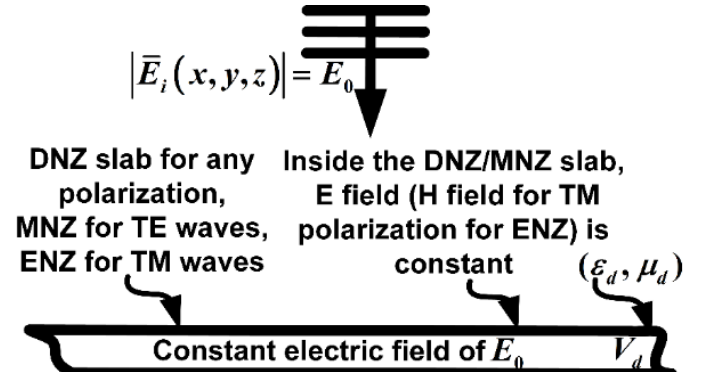
Figure 1. The entire DNZ slab has a constant electric field upon incident of fields with any polari- zation. For TE and TM polarized waves, the same happens if the material is MNZ and ENZ, re- spectively.